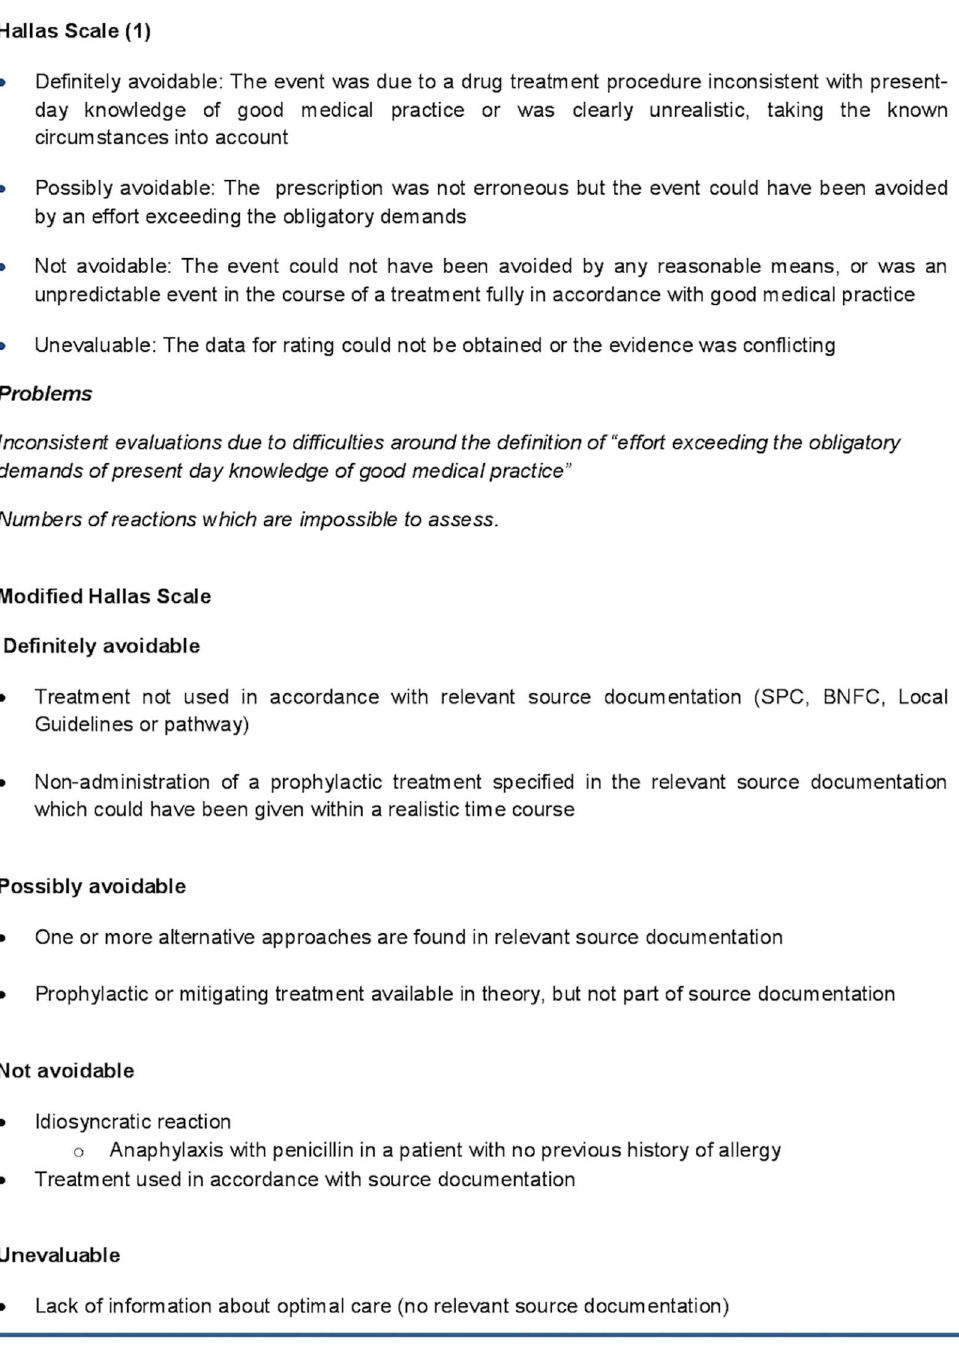
Fig 1. Hallas and the modified Hallas